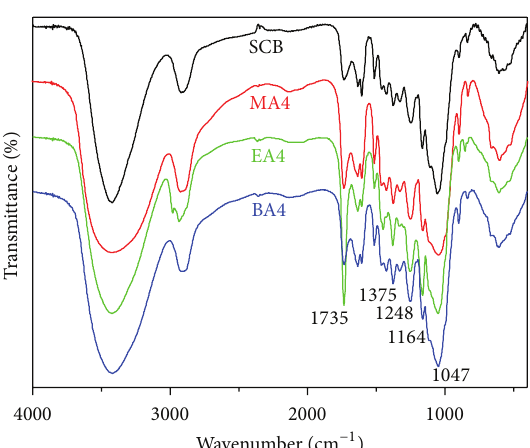
Figure 2: FT-IR spectra of sugarcane bagasse and the graft copoly-